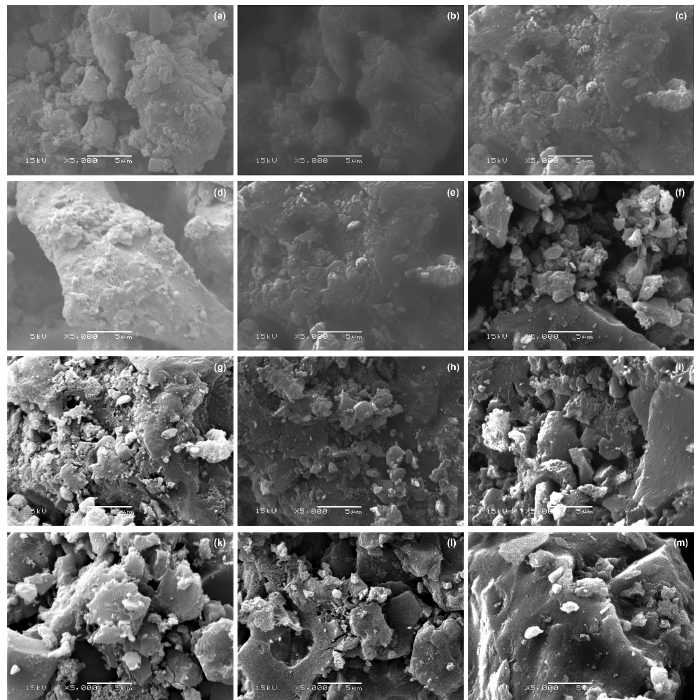
Figure 4. Pictures of scanning electron microscopy (SEM) for samples: ( a ) fresh 5U; ( b ) poisoned 5U; ( c ) regenerated 5U; ( d ) fresh 5U1Cu; ( e ) poisoned 5U1Cu; ( f ) regenerated 5U1Cu; ( g ) fresh 5U5Cu; ( h ) poisoned 5U5Cu; ( i ) regenerated 5U5Cu; ( k ) fresh 5U10Cu; ( l ) poisoned 5U10Cu; ( m ) regenerated